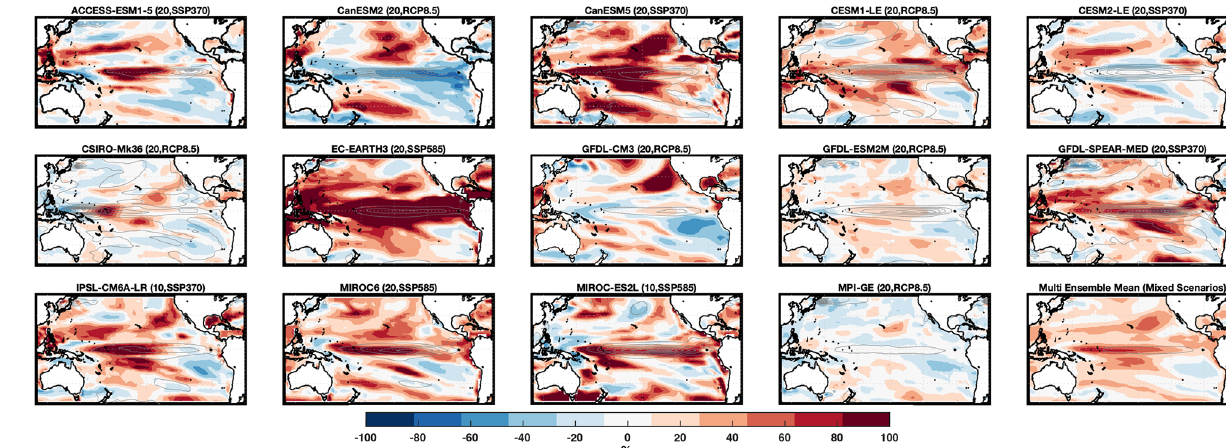
Figure 2. Spatial pattern of relative change in DJF SST variance in the (2–7 years) ENSO band between the late 21st century (2070–2099) simulations and the historical (1951–1980) period. The differences in variance have been normalized by the variance of the historical (1951– 1980) period (contours). The multi-ensemble mean of the individual model ensemble means can be found in the last panel. Red indicates heightened variability, and cool colors indicate dampened variability. For this and following figures using DJF, 30 years are used in the calculations; e.g., for 1951–1980 we include 30 DJFs starting with December 1950 and DJF variance is computed as the variance of the DJF means. We note that a maximum ensemble size of the first 20 members is used in this analysis, with all members of models with 20 or fewer members